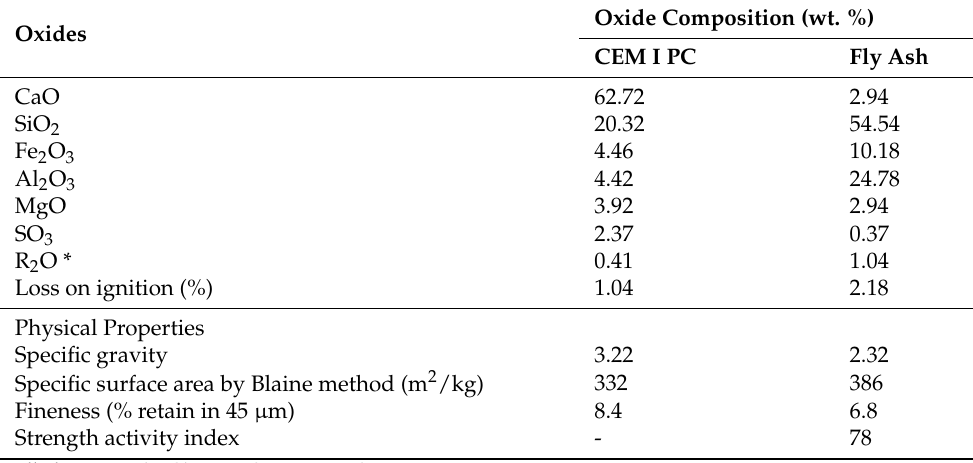
Table 1. Physical characteristics and oxide compositions of cement and fly